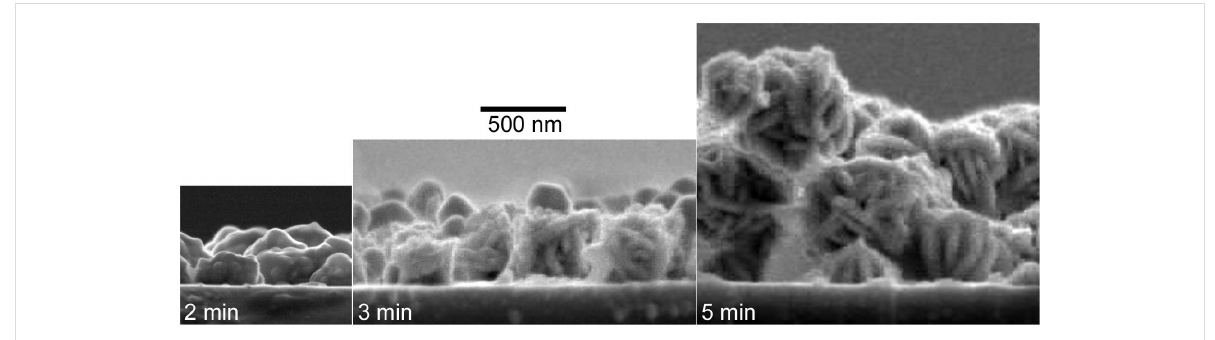
Figure 3: SEM cross-section images of silver EGNP grown from a starting DNA concentration of 25 µM. The reaction times were 2, 3, and 5 min, res- pectively. The scale bar of 500 nm as indicated is valid for all three images.